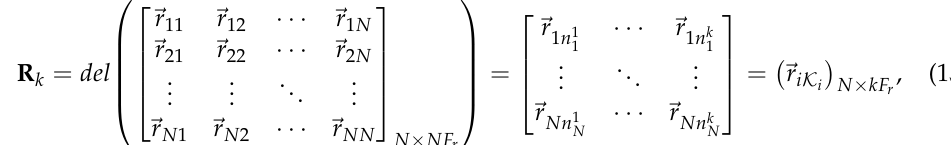
( F is the dimension of vertex state space), and the relations as R = [ (cid:126) r 11 , (cid:126) r 12 , · · · , (cid:126) r 1 N , · · · , (cid:126) r · · · , (cid:126) r ] , (cid:126) r ij ∈ R F r ( F r is the dimension of edge state NN N 1 , N 2 × F r